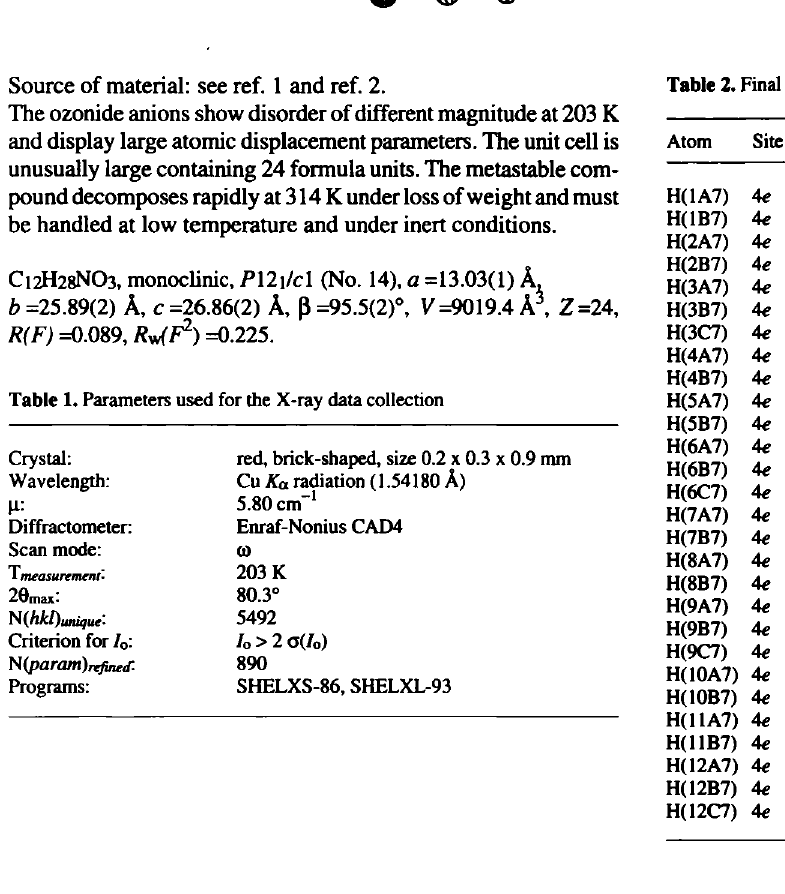
Table 2. Final atomic coordinates and displacement parameters (in Â 2